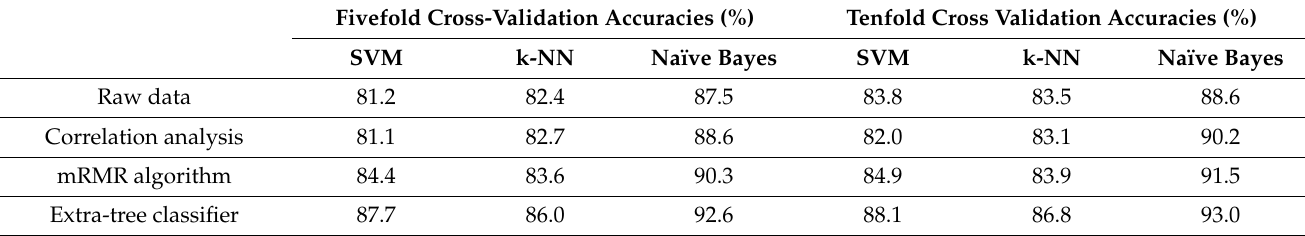
Table 7. Comparison of fivefold and tenfold cross-validation accuracies for the turbine motor fault detection scenario. Fivefold Cross-Validation Accuracies